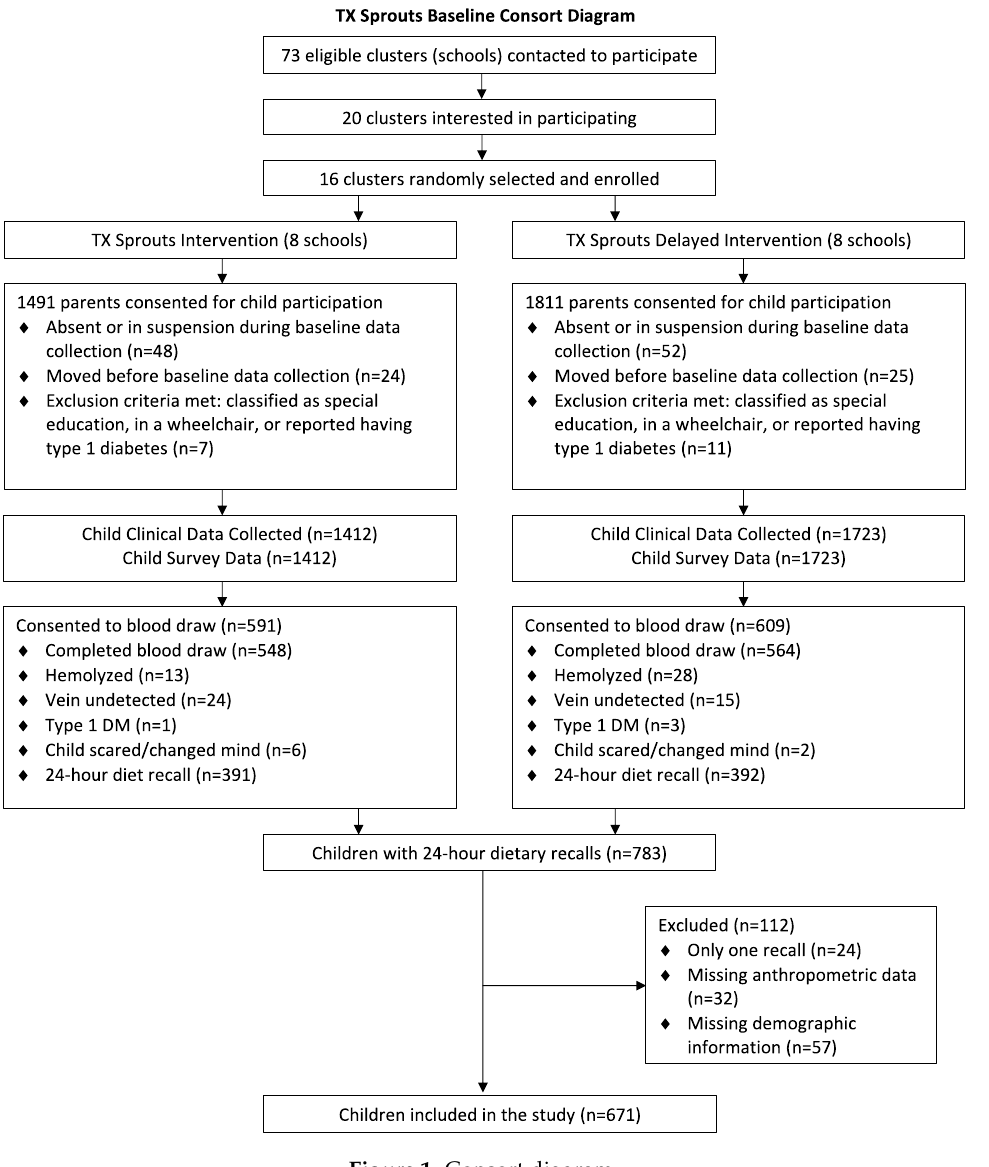
Figure 1. Consort Figure 1. Consort diagram.